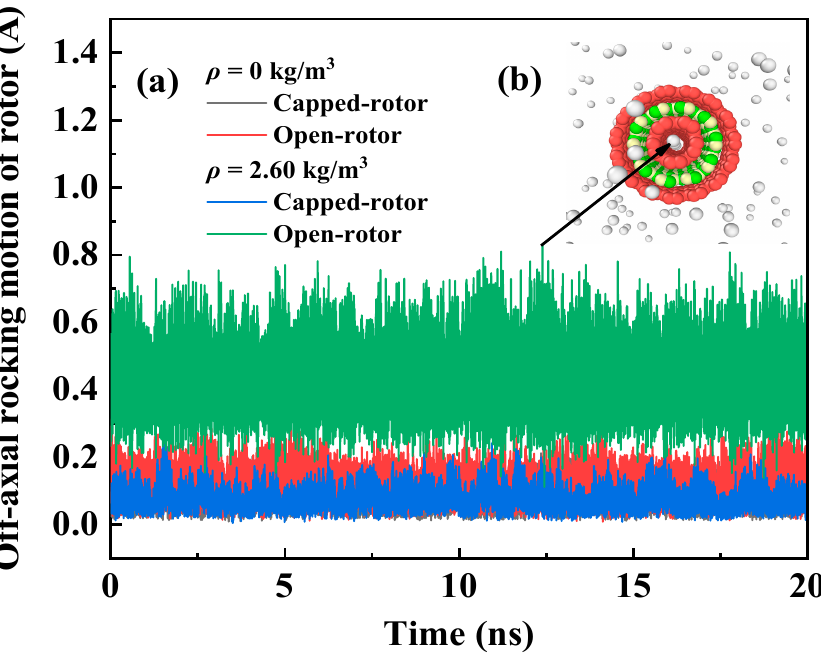
Figure 2. ( a ) Time histories of the off-axial rocking motion of the rotor with different end structures in vacuum and helium environments, and inset ( b ) atomic diagram of the open-RTS at a certain moment.